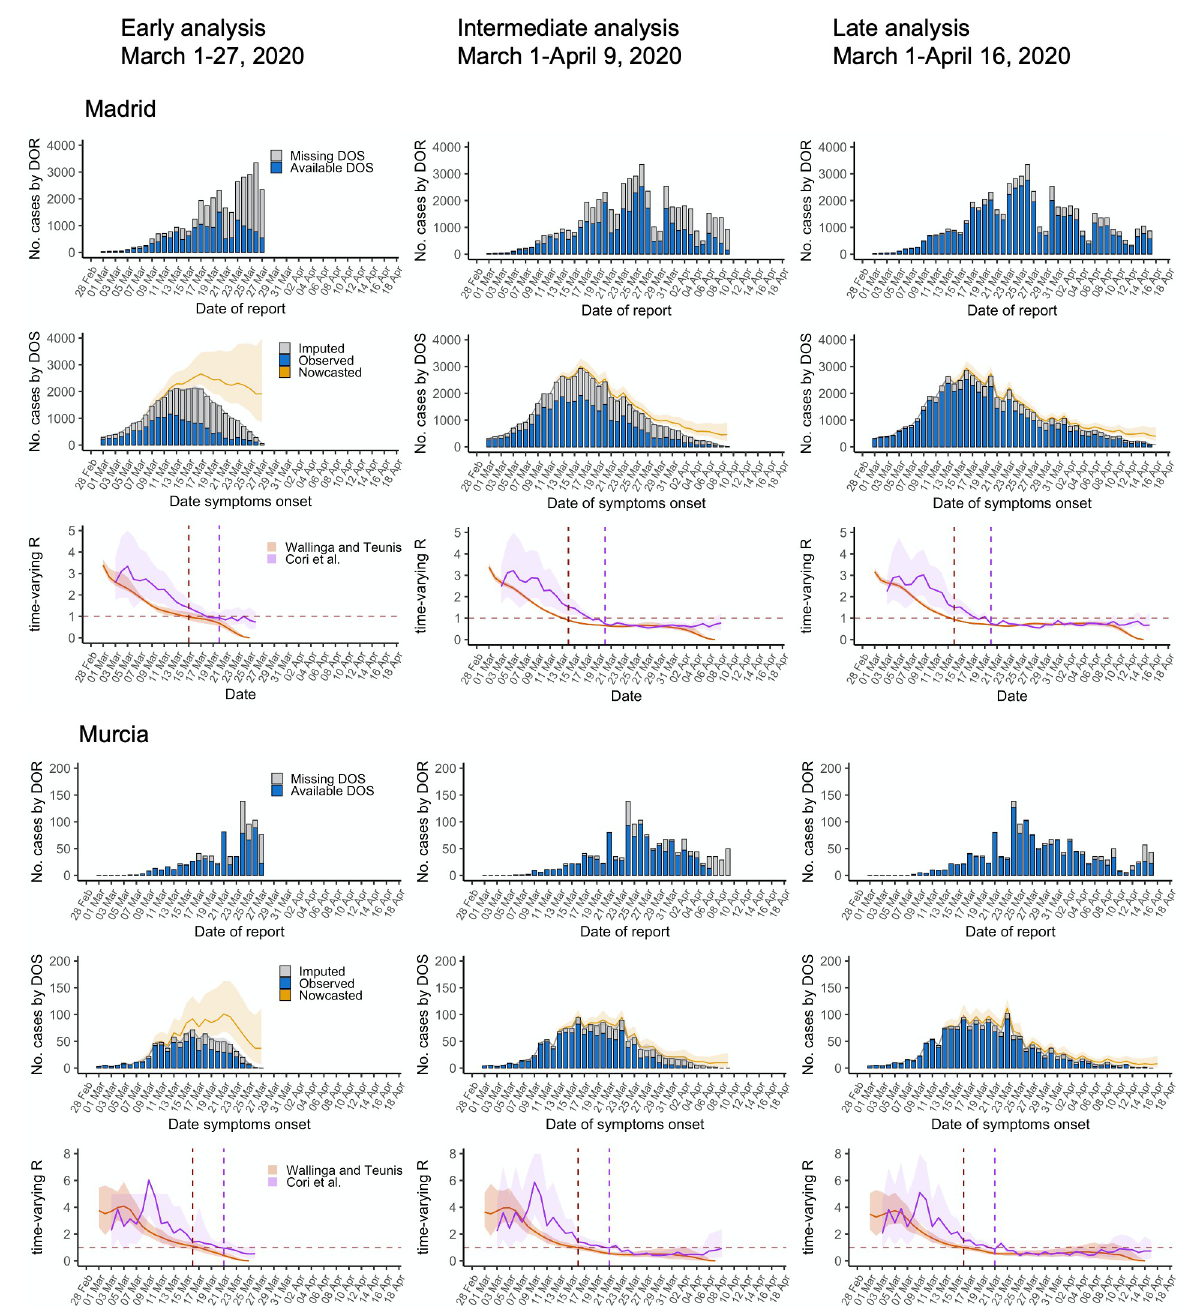
Fig 1. Epidemic curves and reproductive numbers estimated using the data available during the early, intermediate, and late analysis of the initial SARS-CoV-2 outbreak in the regions of Madrid and Murcia, Spain, March 1-April 16, 2020. DOS: date of onset of symptoms; DOR: date of report; Lines are median estimates, ribbons span 2.5 and 97.5 percentiles. Vertical lines indicate the day when R WT, purple dashed line for